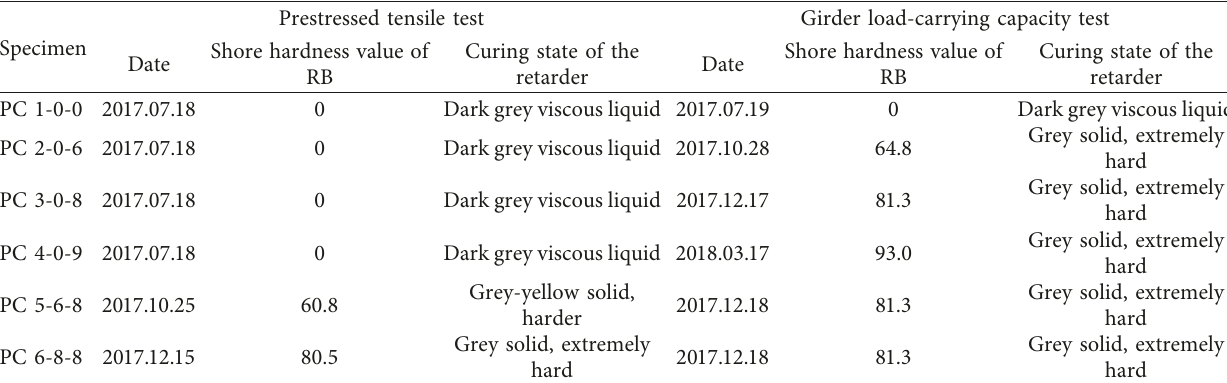
Figure 3: Test Table 1: Properties and states of retard-bonded agent at different degrees of curing.